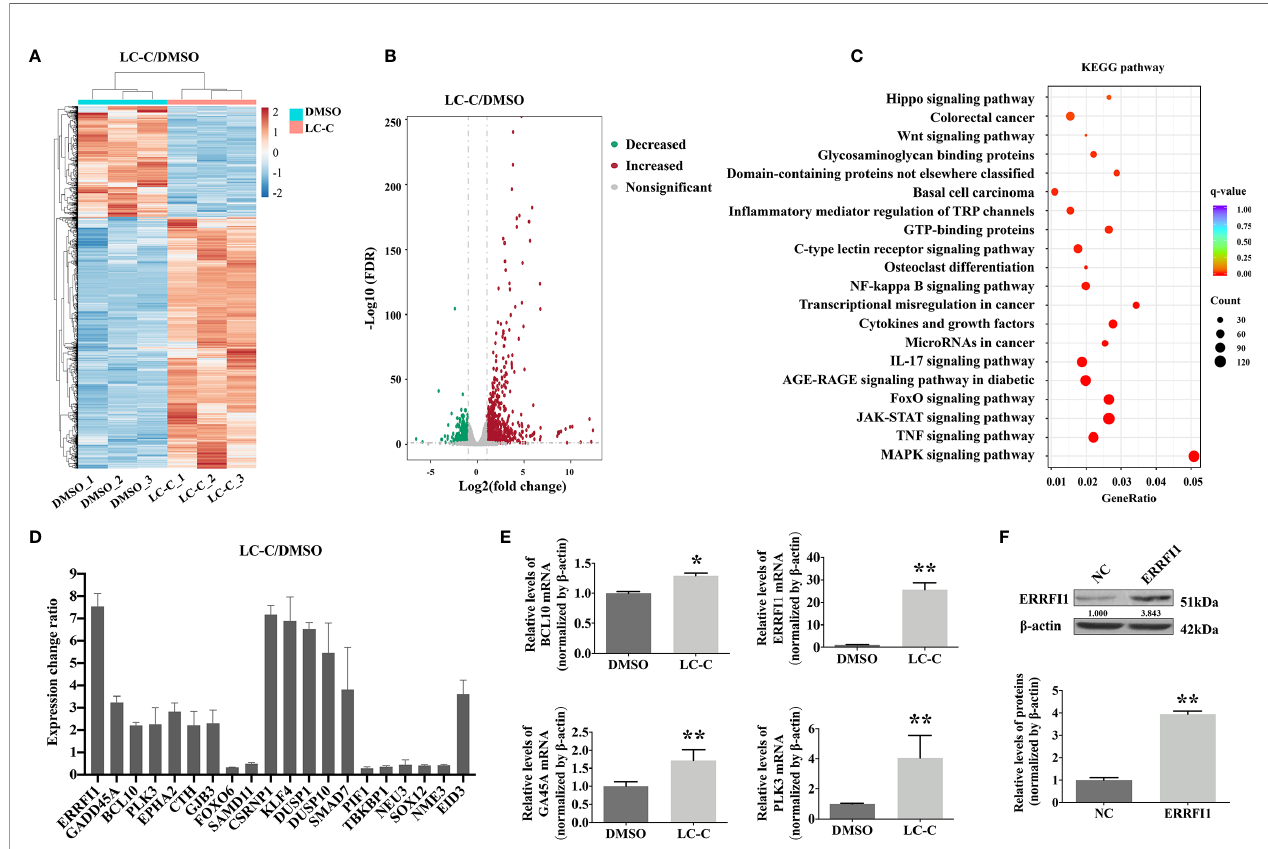
FIGURE 3 | LC-C upregulates ERRFI1 in A549-IR cells. (A) Heatmap of RNA-seq analysis showing altered transcriptome pro fi ling in A549-IR cells treated with LC- C. Red color in the heatmap denotes upregulation and blue color denotes down-regulation. (B) Volcano plot showing the distribution of -log10 (FDR) vs . log2 (Fold Change). Each point represents a gene, red and green points indicate p value < 0.05, while gray points indicate that p value ≥ 0.05. (C) KEGG pathways enrichment analysis. (D) Graph showing expression changes of the top 20 differentially expressed genes from the RNA-seq analysis; (E) RT-qPCR validation of BCL10, ERRFI1, GA45A, and PLK3 upregulation in A549-IR cells after treatment with LC-C. (F) Western blotting showing the overexpression of ERRFI1 in A549-IR cells. Results shown are the means ± standard deviation. *Signi fi cant difference at P < 0.05 level. **Signi fi cant difference at P < 0.01